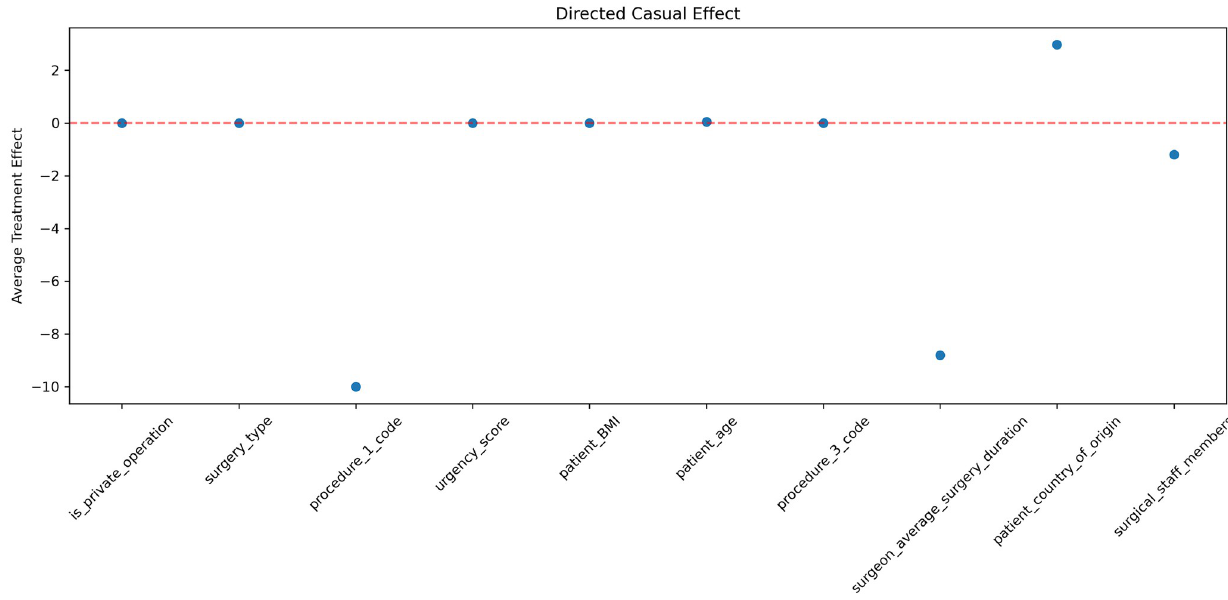
Fig 5. The ATE value of the 10 most influential features by